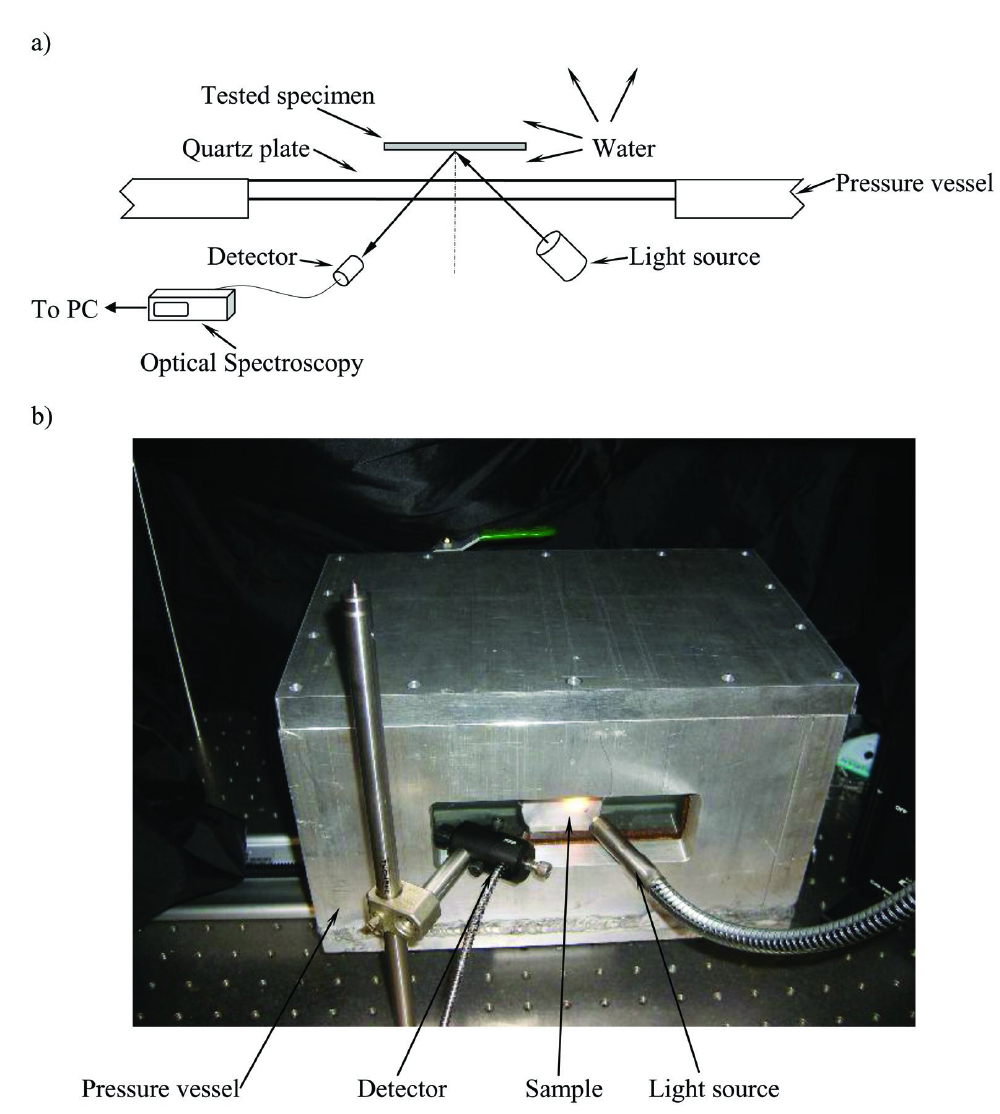
Figure 34. ( a ) Schematic of optical spectroscopy system. ( b ) Photograph of custom pressure vessel. From Samaha et al.